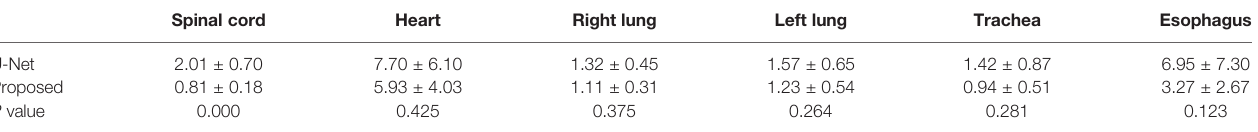
TABLE 4 | Comparison of ASD (mm) of two models ( (cid:2) x ± s ). Spinal cord Heart